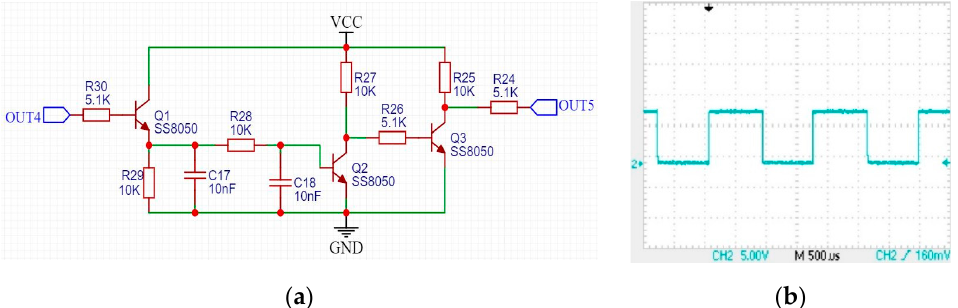
Figure 14. The integrator circuit and its output OUT5: ( a ) integrator circuit ( b ) output OUT5 of the integrator circuit.